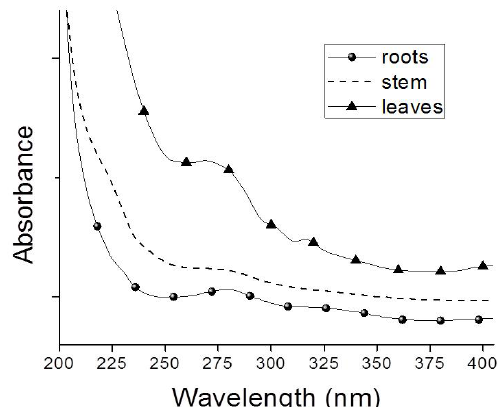
Fig. 1. UV spectra for polyphenols in roots, stem and leave of Eichhornia